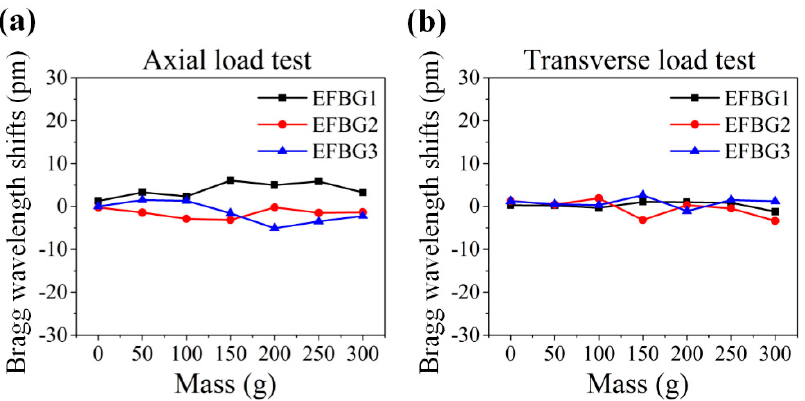
Figure 2. Bragg wavelength shifts of EFBG sensors under ( a ) axial load and ( b ) transverse load.